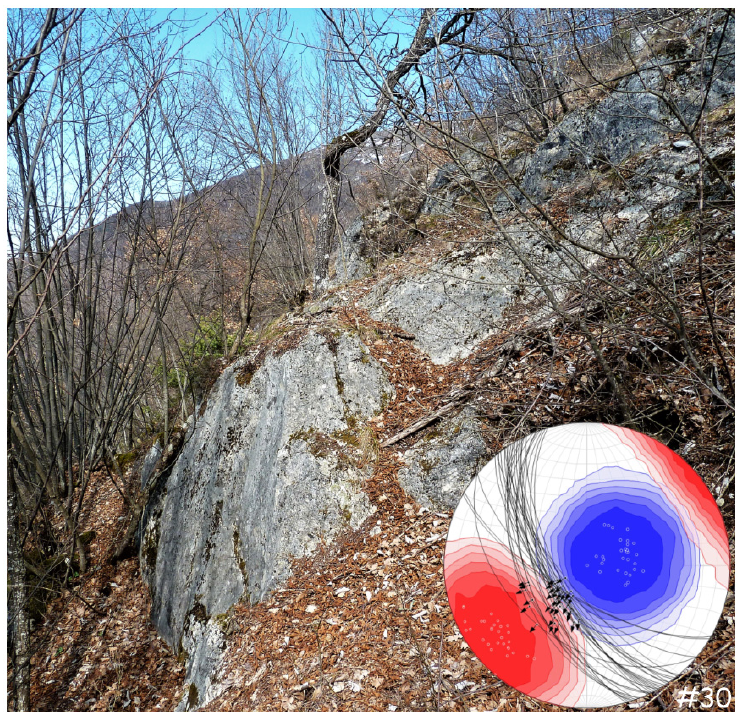
Figure 2 . Rare outcrop of the slickenside along the southern tip of the Norcia fault (NF in Figure 1), and associated stereograms evidencing fault planes, striae and P-axes (blue) and T-axes (red) (modified from density (modified from [23]).